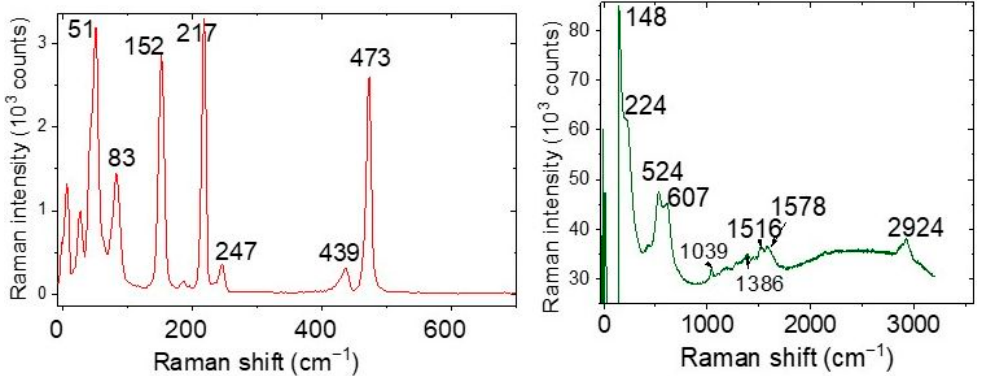
Figure 6. Typical Raman spectra taken on different tip spots using laser excitation at 633 nm.